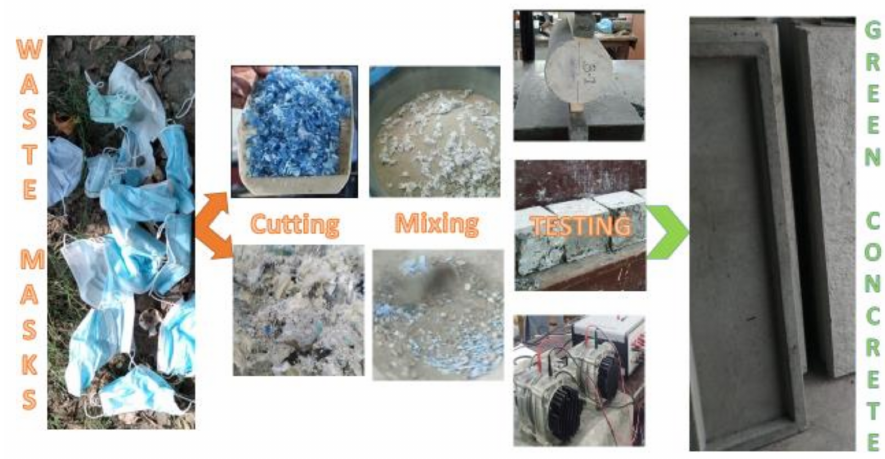
Figure 1. Methodology to use waste masks in concrete.